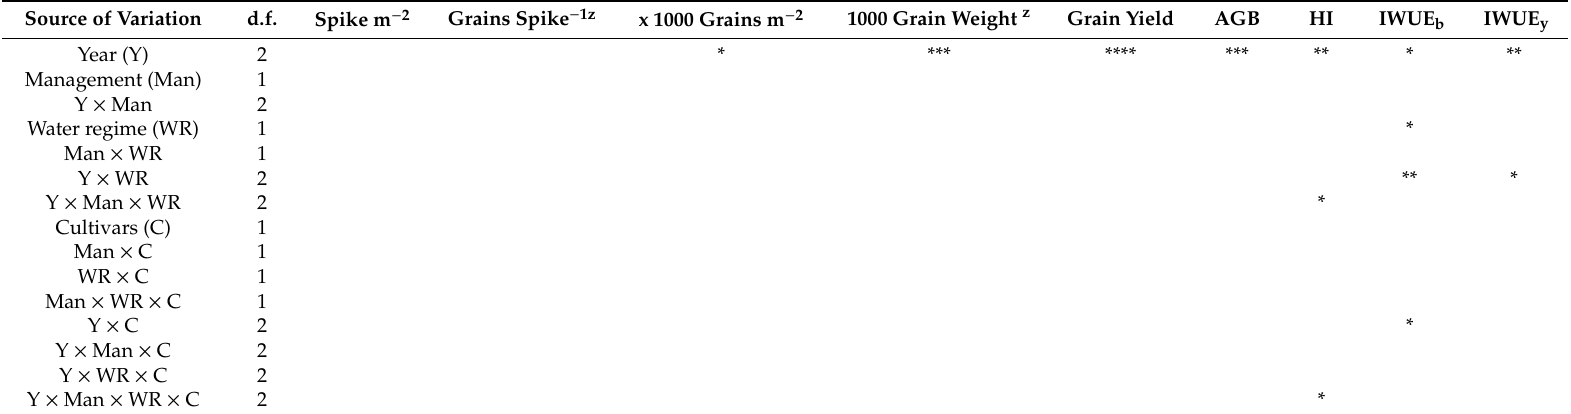
Table 4. Significance levels of analysis of variance over 2012–2013, 2013–2014 and 2014–2015 for the wheat experiment.